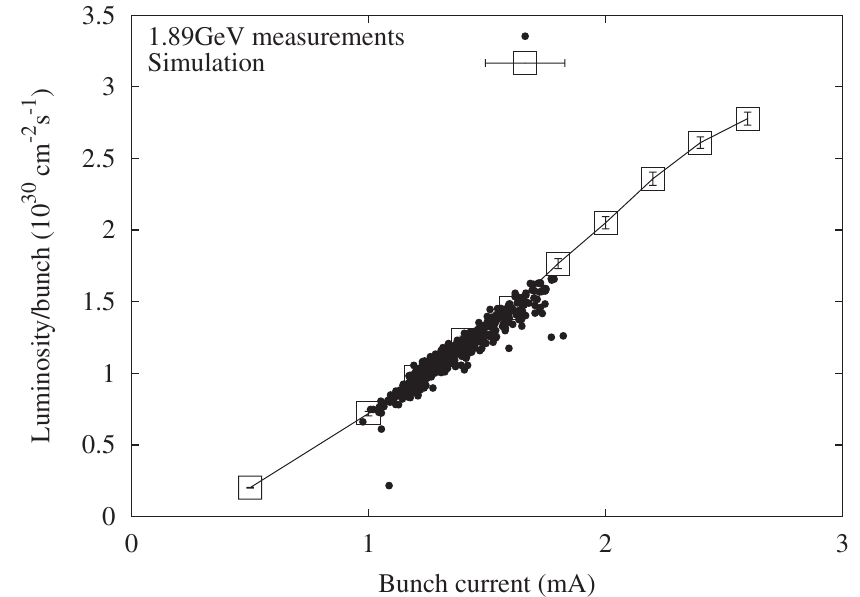
FIG. 8. The measured luminosity points are collected once every 3 min over the 24 h period during which the highest specific luminosity was achieved in the low energy ( CESR - c ) configuration, October 30, 2004. The simulation is based on tracking 500 macroparticles through 10 5